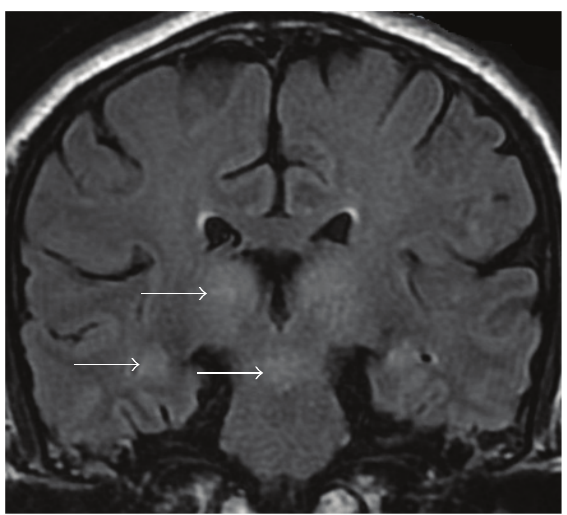
Figure 1: There are widespread abnormal signals at bilateral thala- mus and hippocampus on FLAIR image.